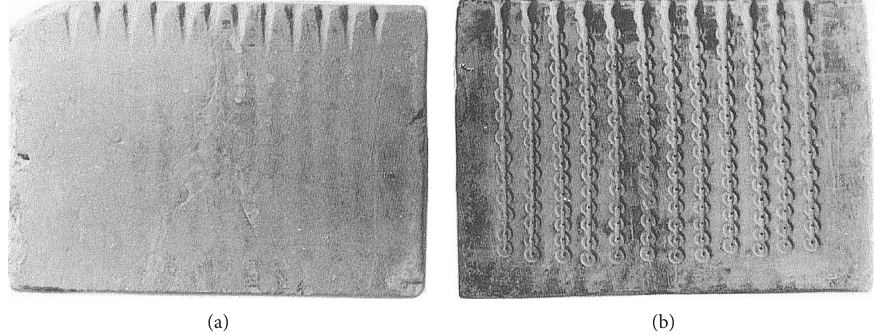
Figure 5: Chalkstone mold found at Khirbet Rafi’, Israel, used to cast coin flans (blanks) (photo from Ancient Jewish Coins by Ya’akov Meshorer/Israel Antiquities Authority, published by Amphora Books, copyright 1982, used with